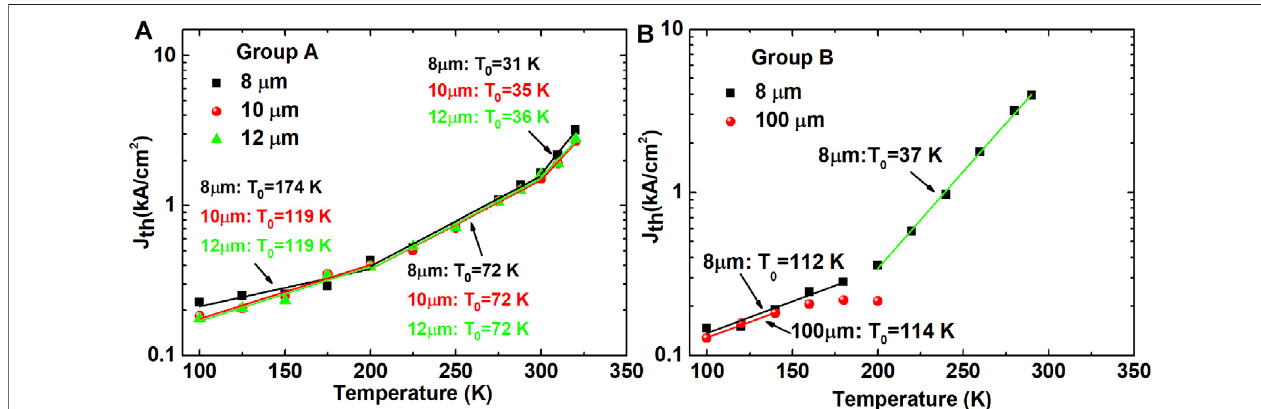
FIGURE 4 | Temperature dependent threshold current density J th for lasers in (A) group A and (B) group B. The symbolsare experimental data. The solid lines are fi tting lines of ln ( J – 200 K, 200 – 300 K, and 300 – 320 K; Group B: 100 – 180 K and 200 – 290 K for the 8- μ m ridge laser, th ) in different temperature ranges. Group A: 100 and 100 – 140 K for the 100- μ m ridge laser.